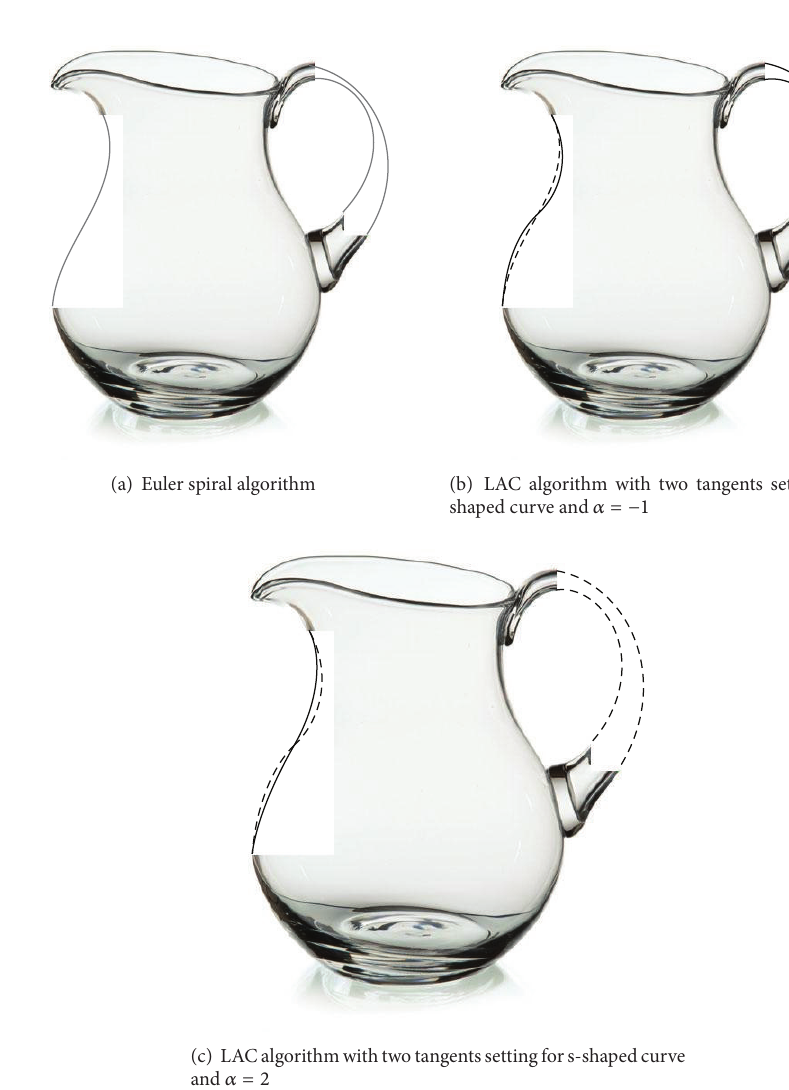
Figure 5: The results of fitting Euler spiral and LAC segment for two missing parts of a